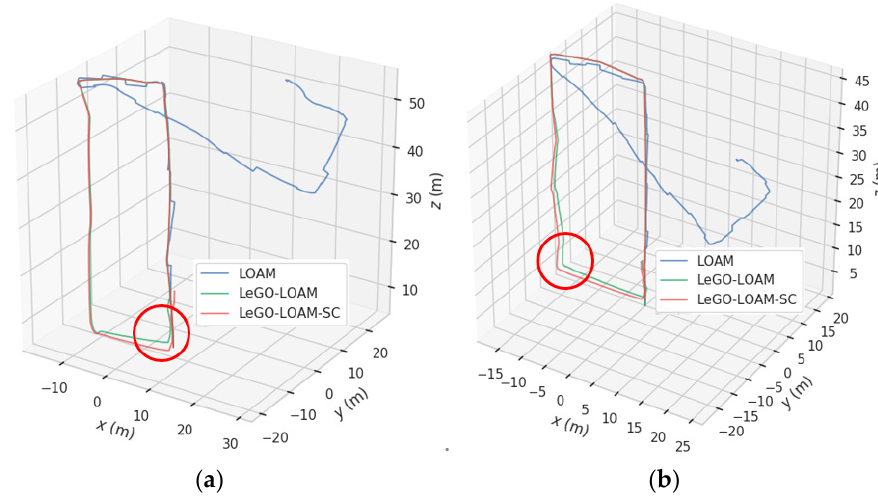
Figure 14. Comparison plots of the LOAM, LeGO-LOAM-SC, and LeGO-LOAM trajectories. ( a ) For scene #1; ( b ) for scene #2. Table 3. The estimation error when returning to the starting position.